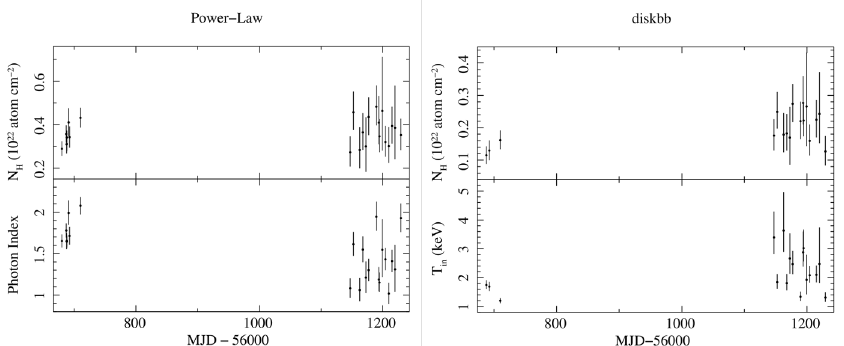
Figure 3. hardness ratio (top panel) and light curve (bottom panel).